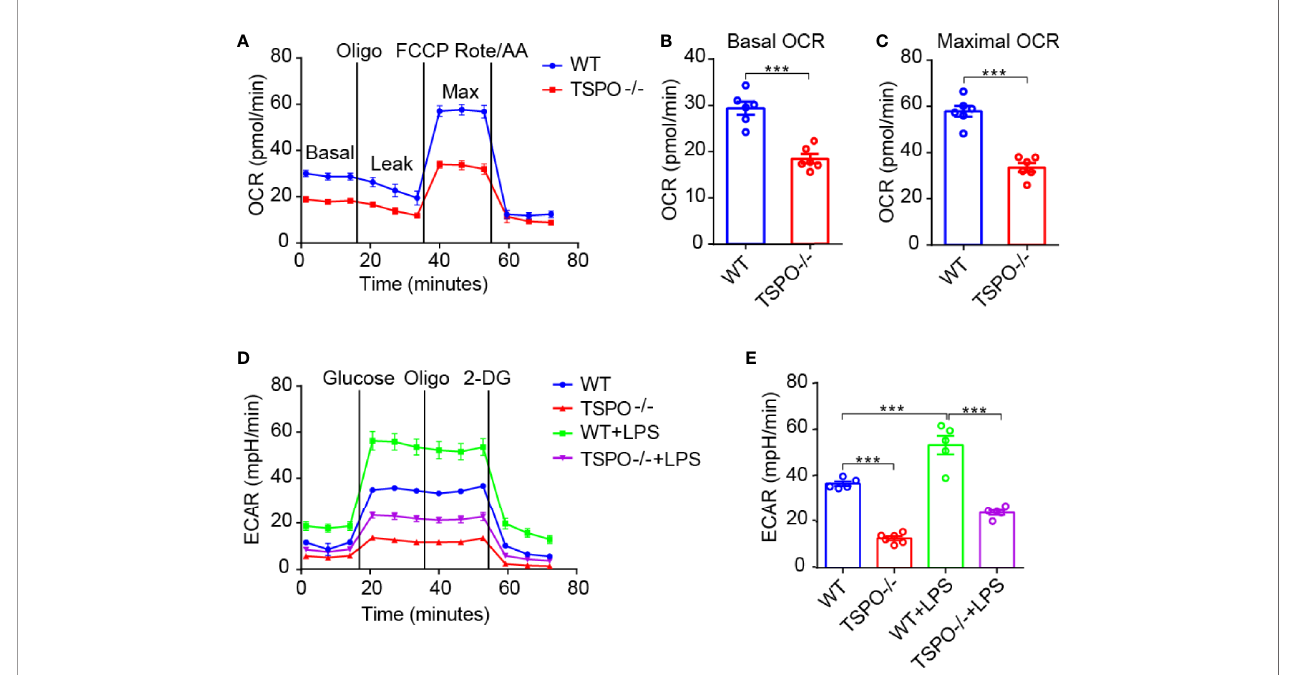
FIGURE 5 | TSPO de fi ciency restrains mitochondrial OXPHOS and glycolysis. (A) OCR measurements of WT and TSPO − / − microglial cells. p-Tri fl uoromethoxy carbonyl cyanide phenylhydrazone (FCCP) is a reversible inhibitor of OXPHOS; Rote and AA are inhibitors of mitochondrial complex I and complex III, respectively. (B, C) Statistics on basic OCR and maximum OCR. (D, E) ECAR measurements of WT and TSPO − / − microglial cells in the presence or absence of LPS (1 µg/ml) treatment for 24 hours. The basal ECAR were calculated. Oligomycin (Oligo) is an inhibitor of ATP synthase; 2-deoxyglucose (2-DG) is a glucose analog. Data are expressed as the mean ± SEM. ***p < 0.001; Student ’ s t-test or one-way ANOVA (B, C) , followed by Tukey ’ s multiple comparison test (E)